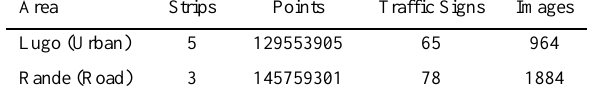
Table 1. Case study data